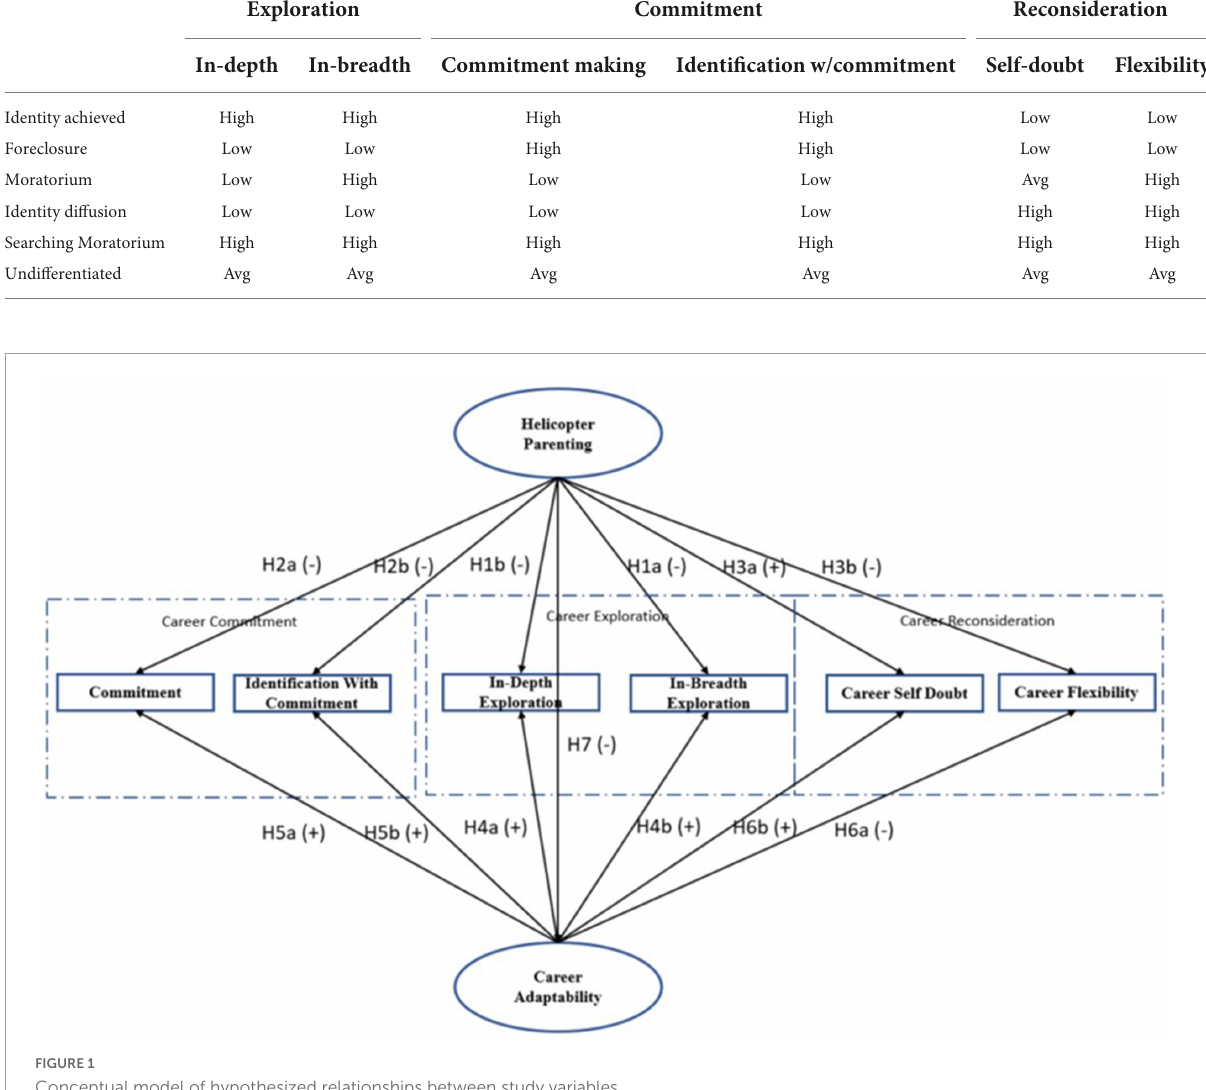
TABLE 1 Summary of identity status composition by dimension scores.